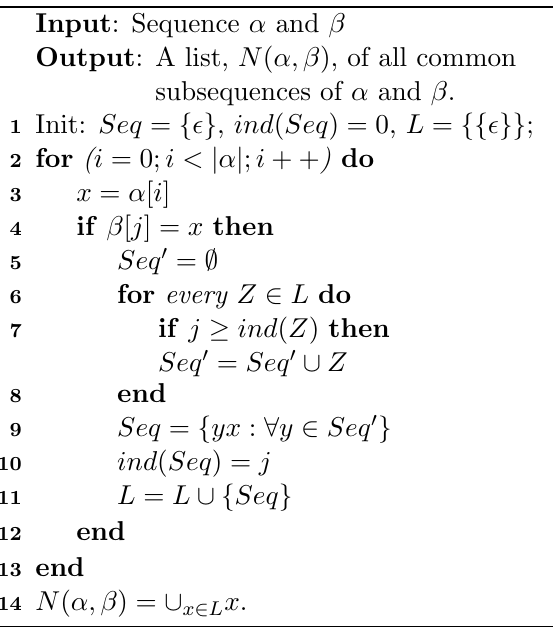
Fig. 7. Finding all common